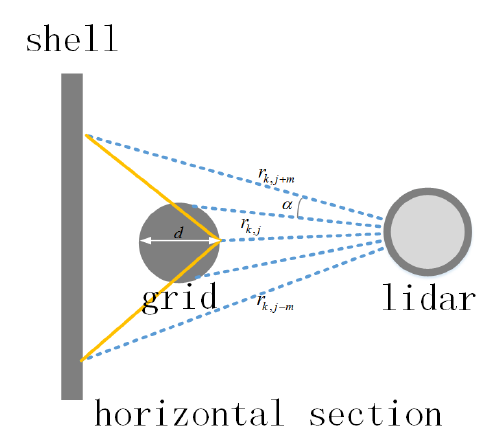
Figure 3. Schematic diagram of the grid feature extraction algorithm. It is a horizontal section view of a spatial grid structure containing vertical truss sections. The blue dotted lines are the lights from the lidar scan points. The yellow lines are an illustration of the “V”